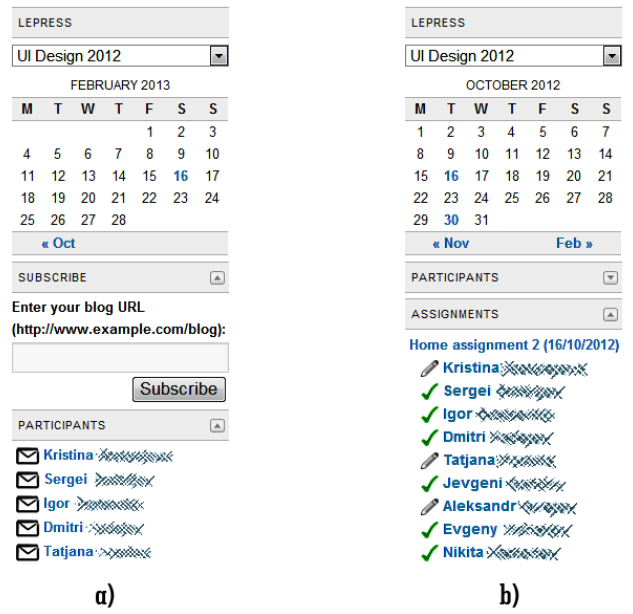
Figure 2 . LePress sidebar widgets for a student (a) and for a teacher (b) (family names are